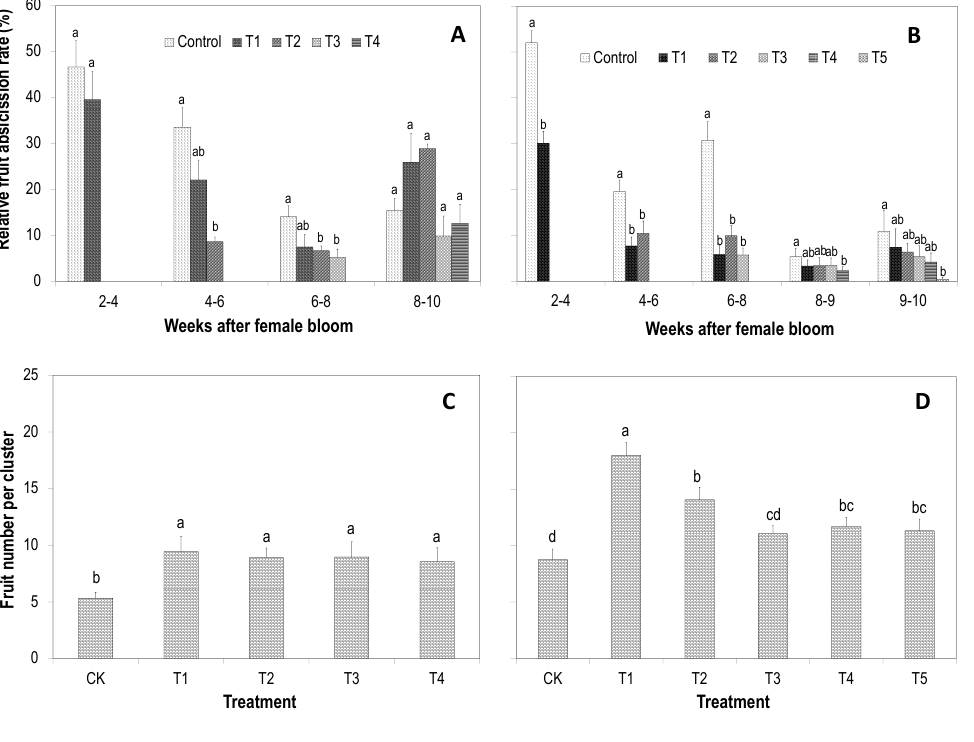
Figure 1. Effect of CPPU treatment at different stages on periodical fruit abscission rate ( A , B ) and final fruit retention at harvest ( C , D ). A and C, results of 2017; ( B , D ), results of 2018. CK represents the control, while T1, T2, T3, T4, T5 and T6 represent spraying 5 mg/L CPPU at 2, 4, 6, 8, 9 and 10 weeks after female bloom, respectively. Different letters above the bars indicate significant difference among treatments at the same duration in the same season at p < 0.05, Duncan’s multiple range test.